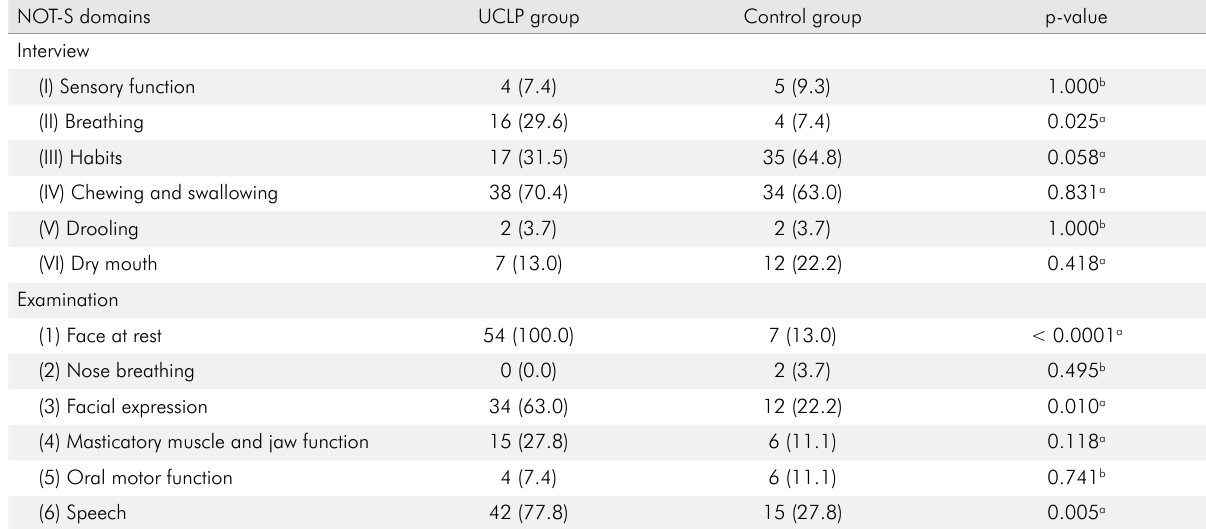
Table 2. Distribution [n (%)] of the NOT-S domains by